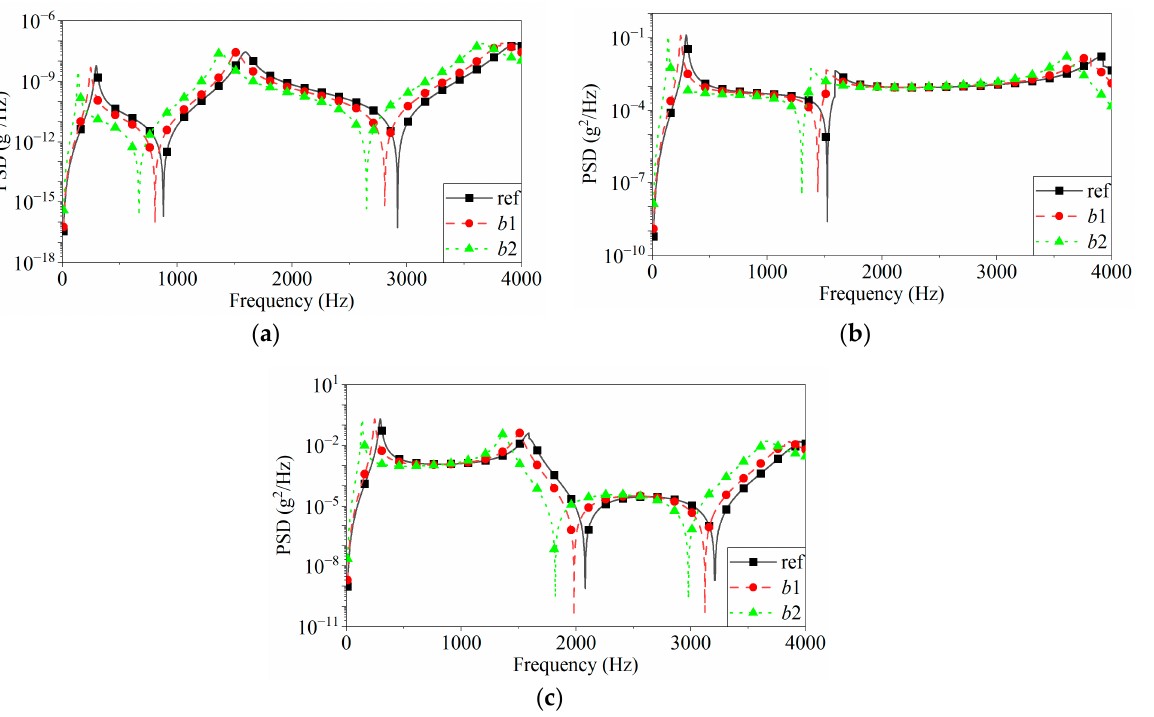
Figure 9. PSD curves of acceleration in the z-direction under different thermal loads at various locations: ( a ) PSD curves for a point located at x = 150 mm ( b ) PSD curves for a point located at x = 100 mm; ( c ) PSD curves for a point located at x = 75 mm.